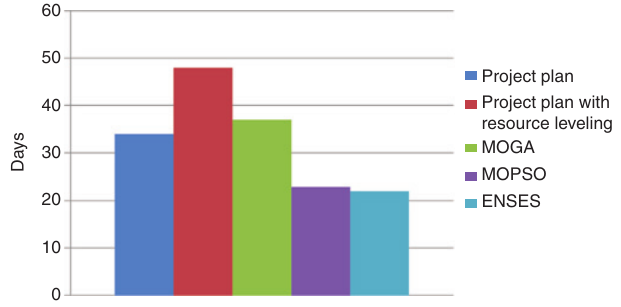
Figure 7: Project Duration of All